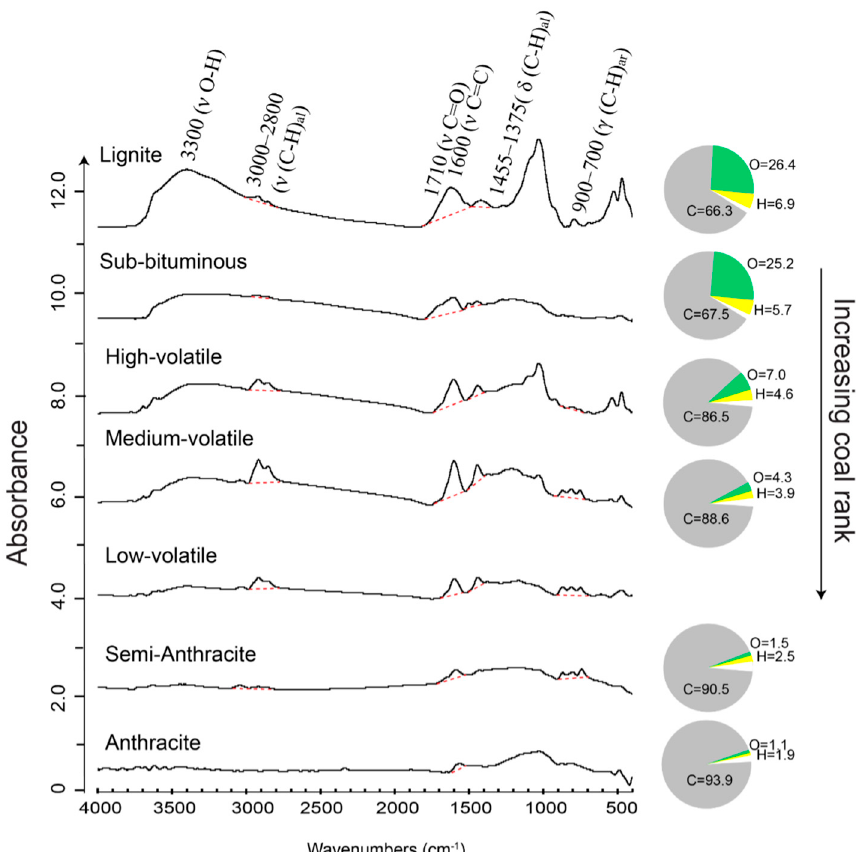
Figure 5. Micro-FTIR spectra of vitrinite in coals of different ranks. Adjacent pie diagrams represent elemental composition of these macerals measured by an electron microprobe. The hydrogen content is calculated by difference [33]. Red dashed lines represent the linear baselines applied to the FTIR spectra. Modified after figure 2 in Chen et al. [26] with copyright permission from Elsevier and Mastalerz and Bustin [33] with copyright permission from Elsevier. The elemental analysis results for low-volatile coal sample are not available.